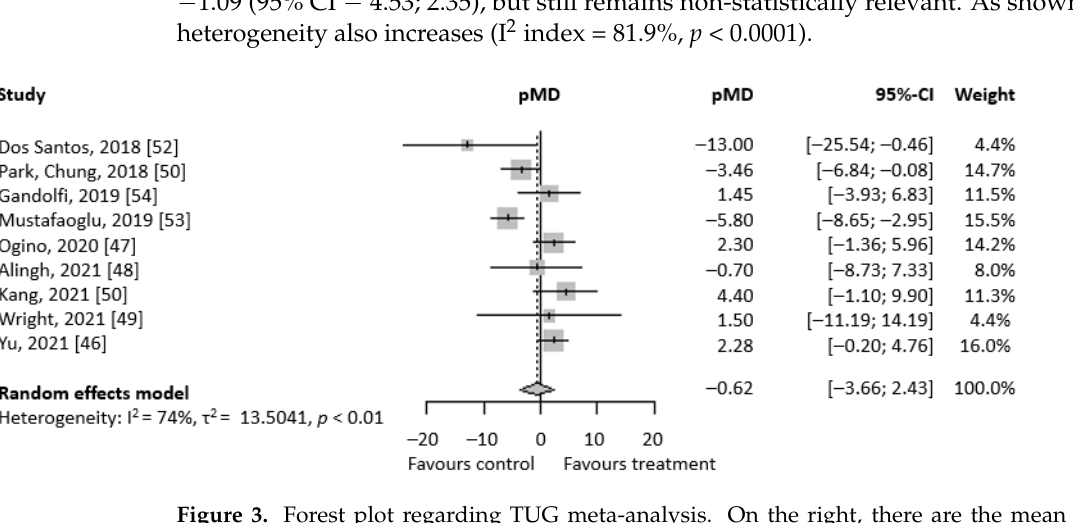
Figure 2. Forest plot regarding BBS meta-analysis. On the right, there are the mean pre-post differ- ence of each selected study and their respective 95% CI. At the bottom, there are total pMD, its 95%CI, and heterogeneity evaluation.